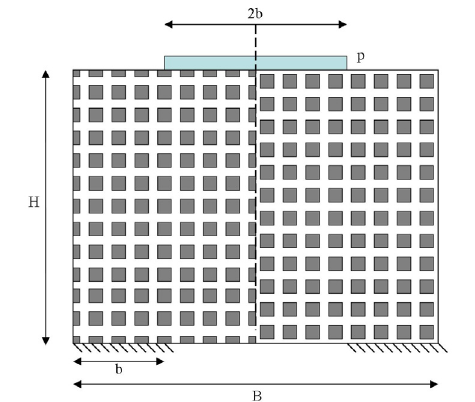
Figure 3: Schematic of the rectangular wall: geometry, loading and boundary